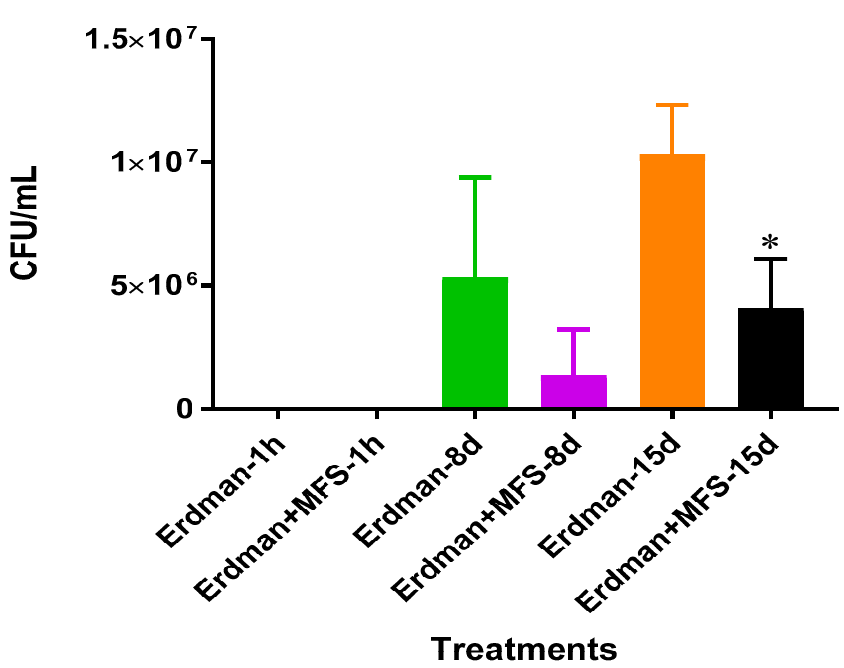
Figure 1. Growth of Mtb Erdman in 7H9 containing MFS. Experiments were performed in order to determine direct mycobacterial effects of each treatment. Data represent means ±SE from 1 trial and plating it multiple times. * p < 0.05 when comparing samples to their respective controls.